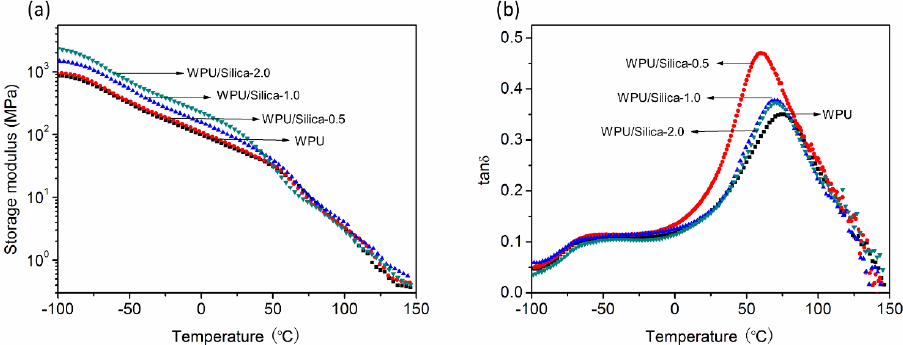
Figure 10. ( a ) Storage modulus ( E ′) and ( b ) loss factor (tanδ) of WPU and WPU/Silica coatings.